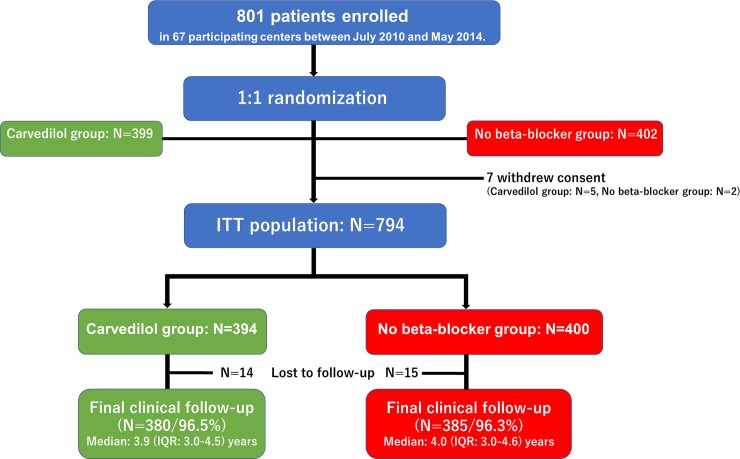
Study flow chart.ITT = intention-to-treat; IQR = interquartile range.